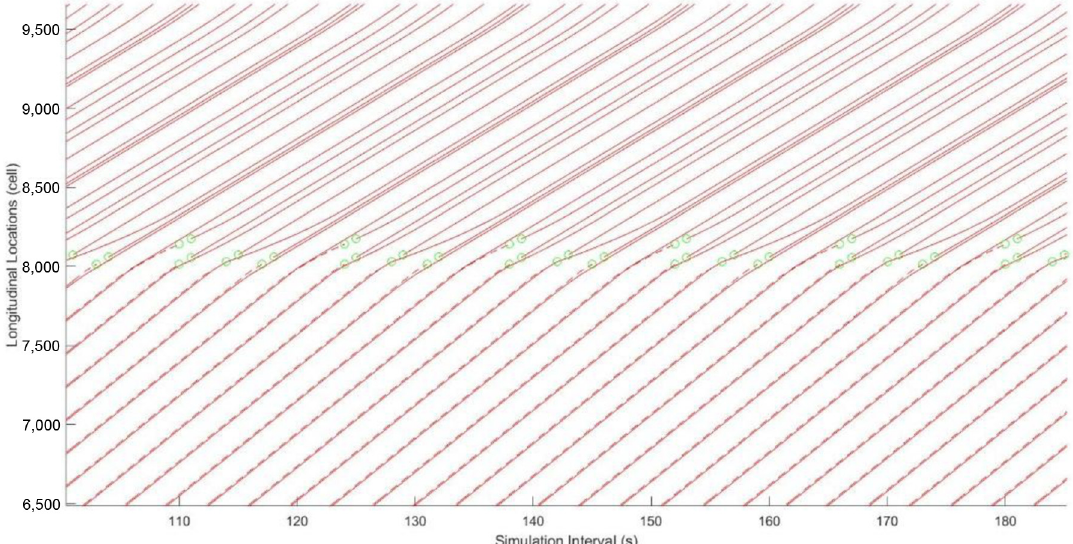
Figure 8 Trajectories with penetration rate being 100 per cent